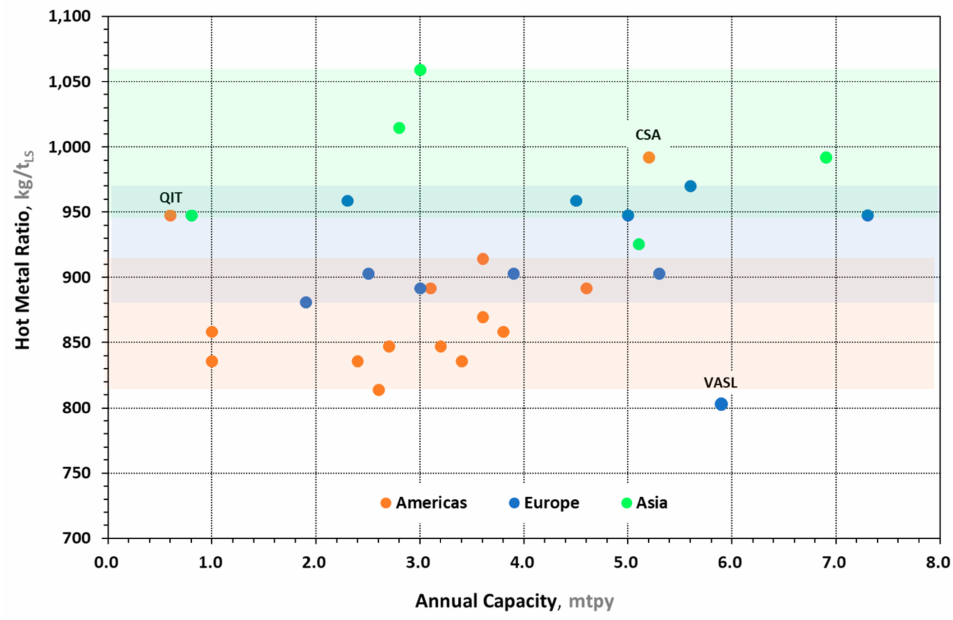
Figure 7. Overview of hot metal ratio of steel producers